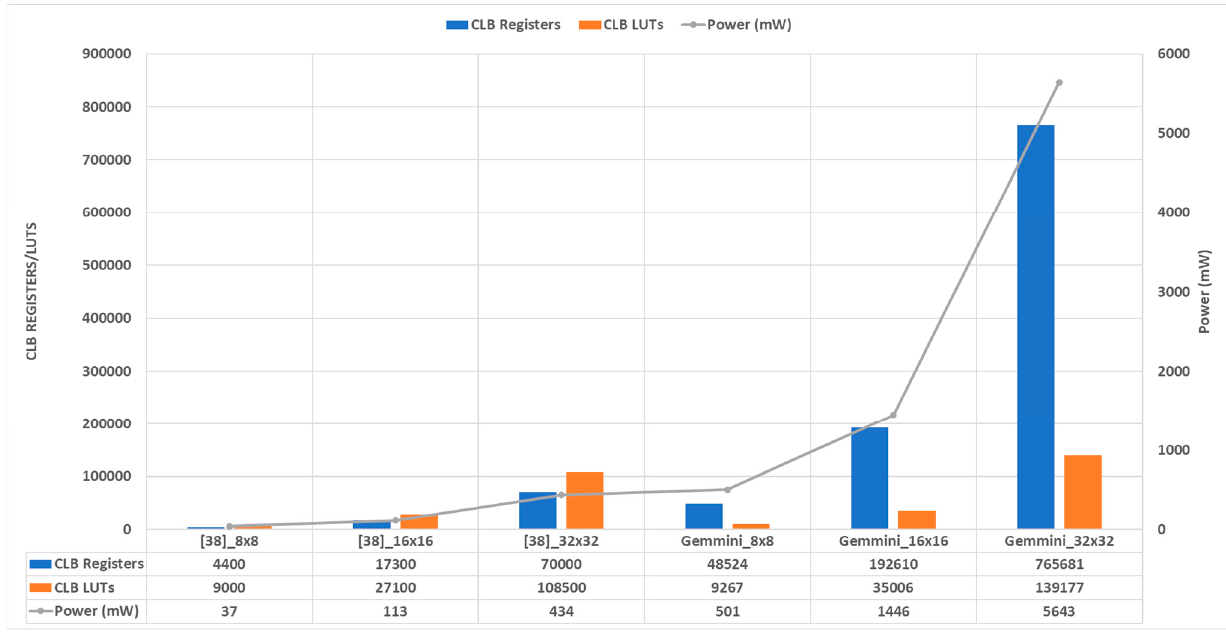
Figure 17. Systolic array hardware resource